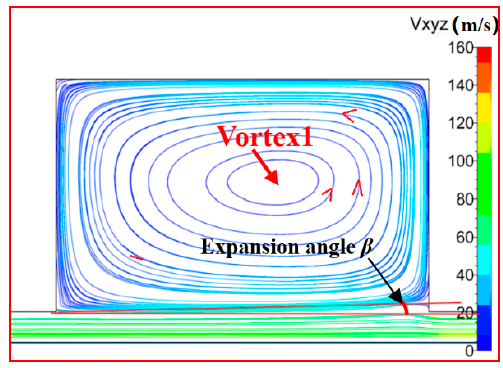
Figure 9. Internal streamline of SCO 2 as working fluid.